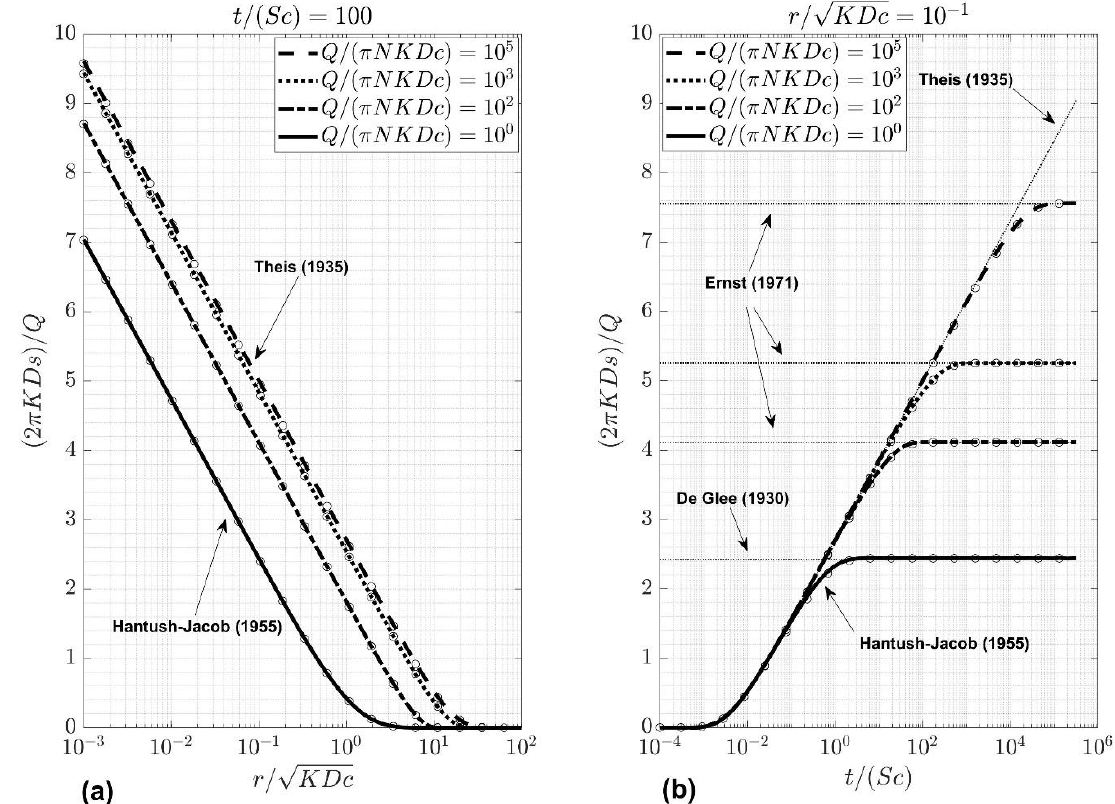
Figure 4. Transient state solution of the Ernst model developed in this study. ( a ) Dimensionless drawdown (2 π KDs )/ Q as a function of dimensionless distance r /( KDc ) 1/2 for dimensionless time t /( Sc ) equal to 100 and for different dimensionless pumping rates Q /( π NKDc ). ( b ) Dimensionless drawdown (2 π KDs )/ Q as a function of dimensionless time t /( Sc ) for dimensionless distance r /( KDc ) 1/2 equal to 0.1 and for different dimensionless pumping rates Q /( π NKDc ). K is the aquifer conductivity, S the storativity, D the saturated thickness, c the drainage resistance, N the infiltration flux, Q the pumping rate, s the drawdown, r the radial distance, and t the time. See text for definitions. The solution is verified against the finite-difference approach (circles), and against the asymptotic solutions developed by de Glee, Theis, Hantush and Jacob, and Ernst.